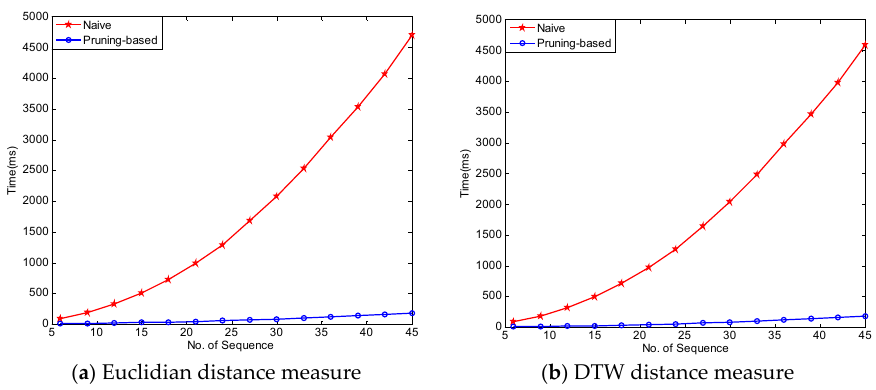
Figure 10. Performance of naïve and pruning-based distance matrix calculation algorithms vs. number of sequences.